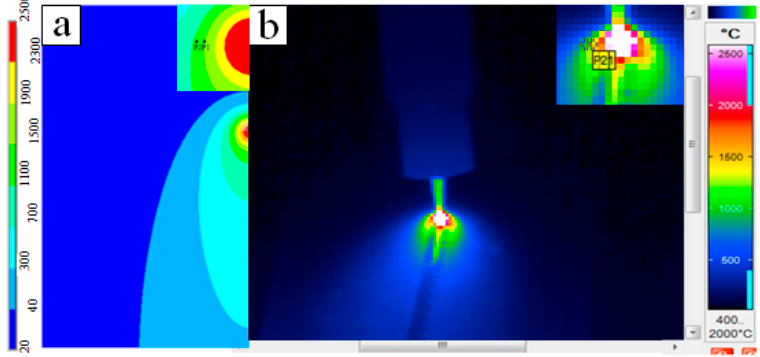
Figure 5. ( a ) The simulated temperature field and ( b ) the measured surface temperature field using the infrared thermograph.